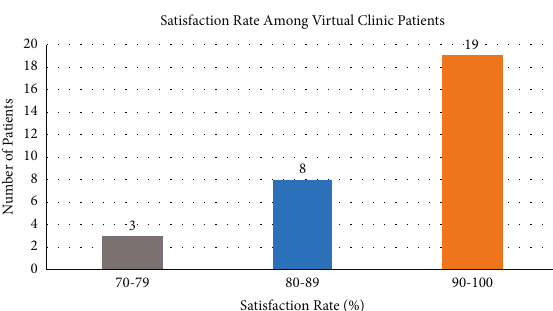
Figure 4: Satisfaction rate among virtual clinic patients.